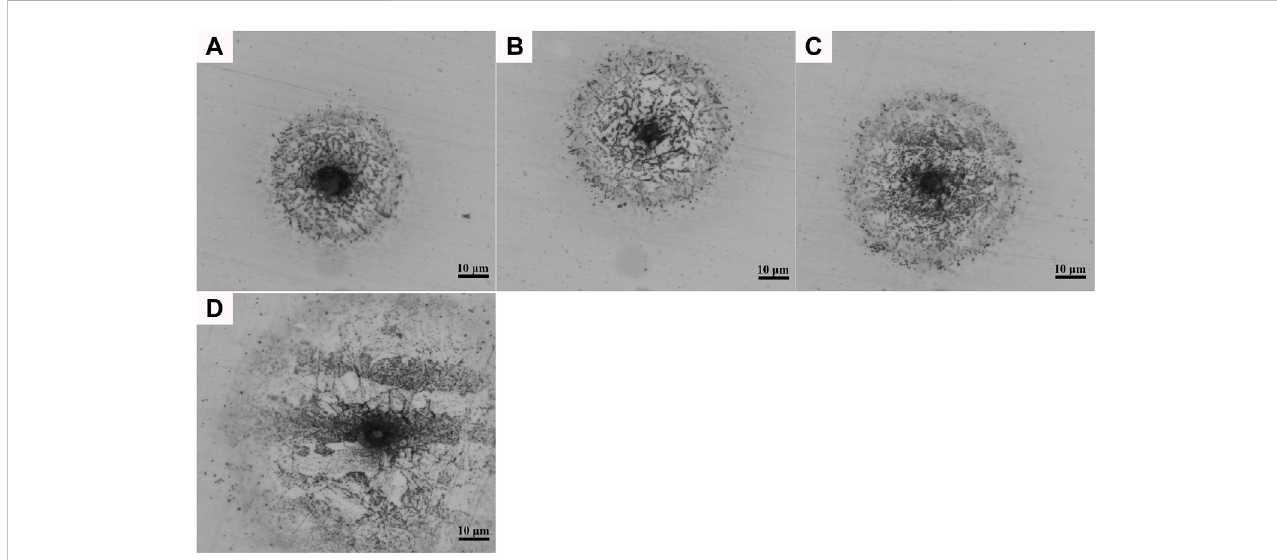
FIGURE 7 Metallography of stable pitting corrosion in the HAZs: (A) CGHAZ; (B) FGHAZ; (C) ICHAZ; (D) BM.